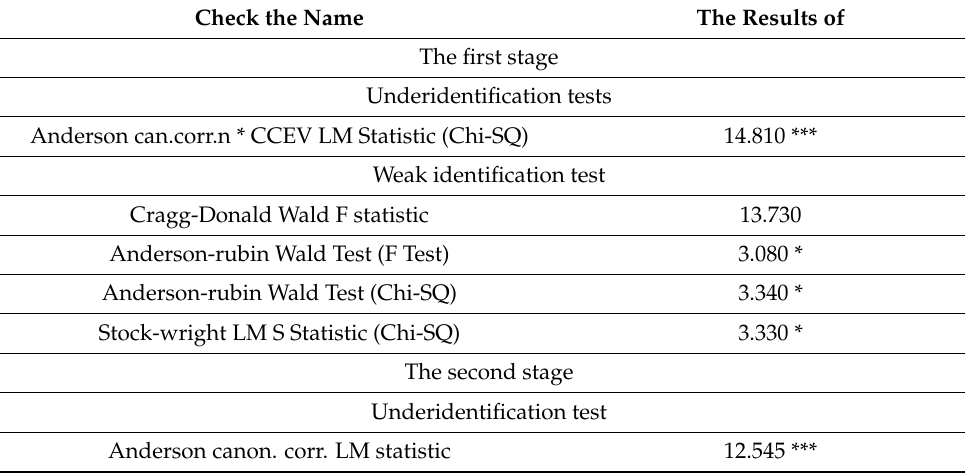
Table 6. Instrumental variables reasonableness